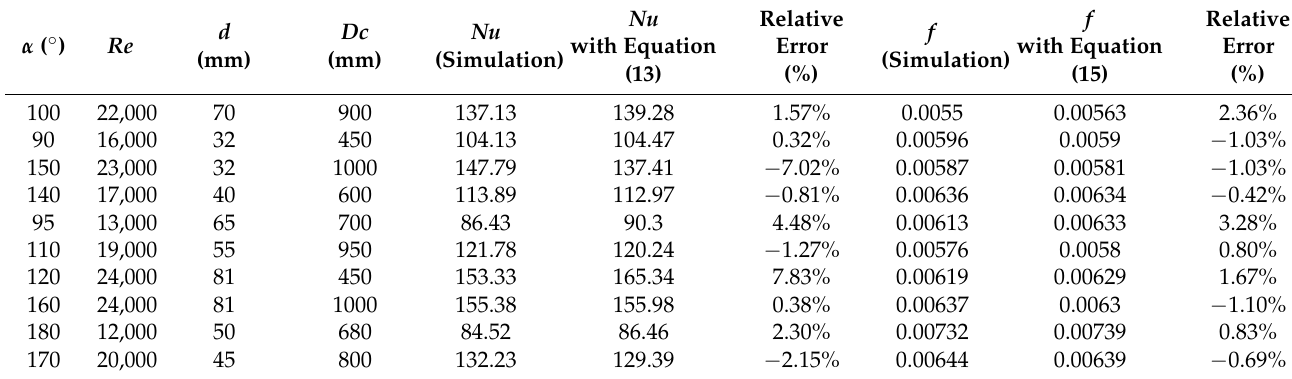
Table 5. Verification of the modified formula for helical